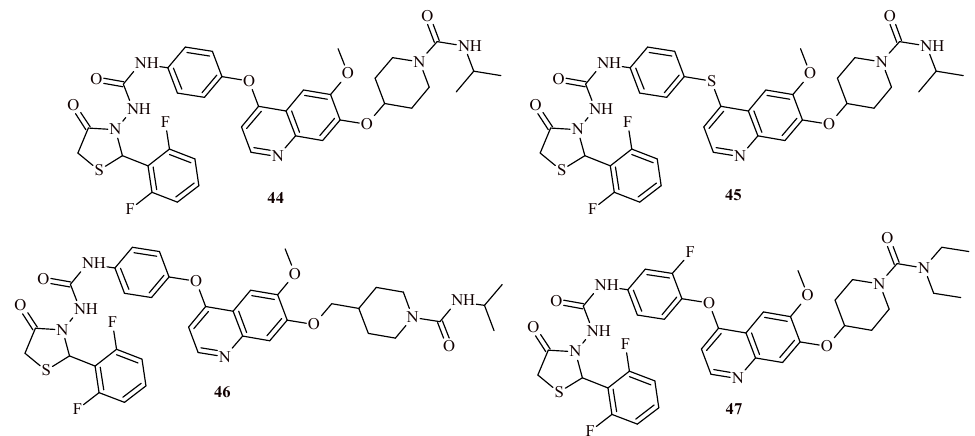
Figure 19. The structures of quinoline-based 2-(2,6-difluorophenyl)-thiazolidin-4-one derivatives as kinase inhibitors for the treatment of colorectal cancer. The modification of ureidophenoxyl and piperidine-1-carboxamide moieties by 2- fluoro and diethyl substituents led to obtaining more effective (Compound 47 ) anticol- orectal cancer agent than Compound 44 . The IC 50 value of 47 was 0.19 ± 0.012 µM, % of inhibition was 76.3 and 89.3 against c-Met and Ron kinases [51]. Kobylinska et al. reported anticancer activity of Les-3833 comparable to doxorubicin against human glioma and rat glioma cells as well as human melanoma cell lines (Figure 20). Their IC 50 were 0.84 ± 0.09 (Les-3833) vs. 0.90 ± 0.11 (doxorubicin) µg/mL (U251), 0.89 ± 0.12 vs. 0.84 ± 0.08 µg/mL (C6), 0.22 ± 0.03 vs. 0.24 ± 0.05 µg/mL (WM793) and 0.30 ± 0.04 vs. 0.35 ± 0.06 µg/mL (SK-MEL-28) [52]. Moreover, in silico studies of Les-3833 showed the affinity to topoisomerase II inhibitor, and high possibility for inhibitory interaction with ChekPoint kinase-1, caspase-6 and caspase-8 [53].